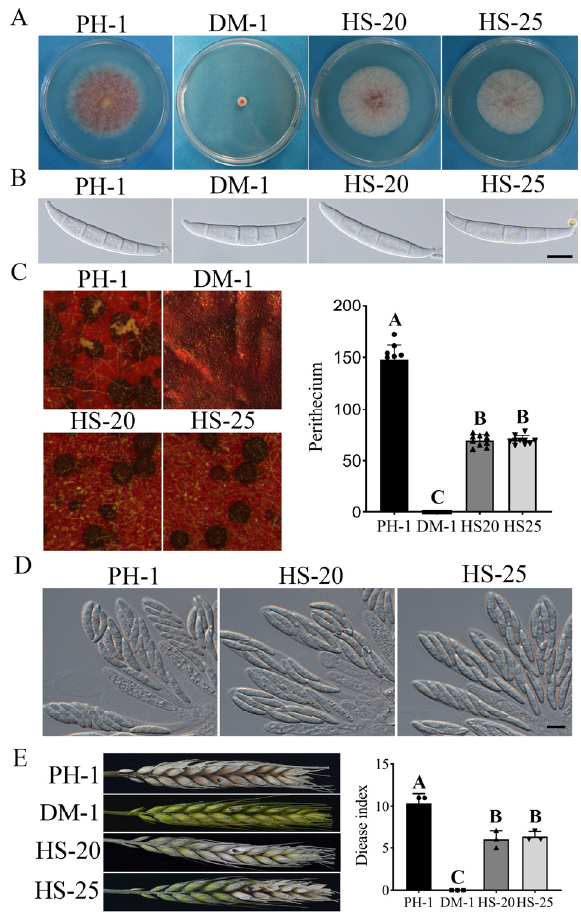
Figure 2. Spontaneous suppressor strains recovered in growth rate, sexual development, and virulence. ( A ) Three-day-old PDA cultures of the wild-type strain PH-1, DM-1, HS-20, and HS-25. ( B ) Conidiation of the wild-type strain PH-1, DM-1, HS-20, and HS-25 after cultivation in CMC for five days. Bar = 20 µm. ( C ) Carrot agar cultures of PH-1, DM-1, HS-20, and HS-25 were examined 7 days post-fertilization (dpf) and assay of perithecia of the wild-type strain PH-1, DM-1, HS-20, and HS-25. ( D ) Ascospores of the wild-type strain PH-1, HS-20, and HS-25 were examined by differential interference contrast (DIC). Bar= 10 µm. ( E ) Flowering wheat heads were drop-inoculated with conidia of the same set of strains and photographed 14 days post-inoculation (dpi). Black dots mark the inoculated spikeletes. Different letters indicate significant differences based on ANOVA analysis followed by Duncan’s multiple range test ( p = 0.01) in A, B, C.